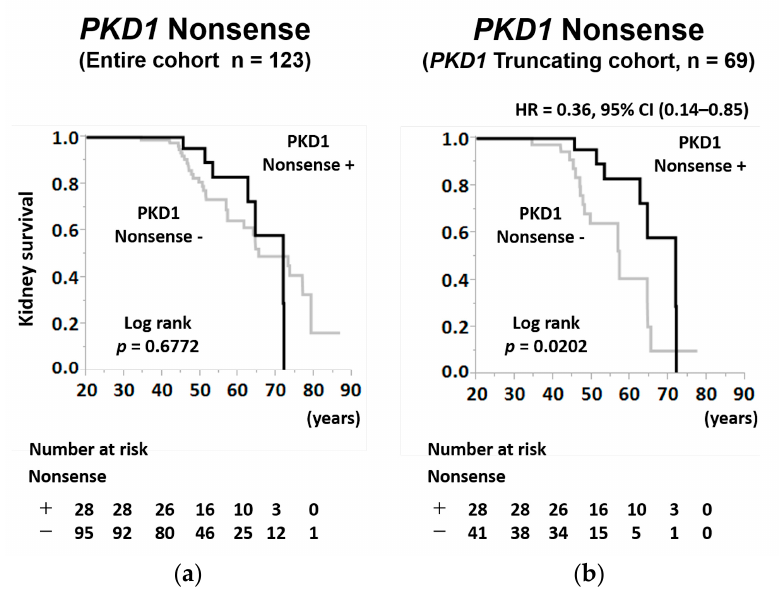
Figure 4. Kidney survival rate of patients with ADPKD stratified by PKD1 nonsense mutation in the entire and PKD1 truncating cohort. ( a ) The kidney survival rates of ADPKD patients with PKD1 nonsense mutation or without PKD1 nonsense mutation in the entire cohort (log-rank, p = 0.6722). ( b ) The kidney survival rates of ADPKD patients with PKD1 nonsense mutation or without PKD1 nonsense mutation in the PKD1 truncating cohort (log-rank, p = 0.0202). The number of patients at risk for progression to RRT at each time point is mentioned below the figures; HR = hazard ratio; CI = confidence interval.